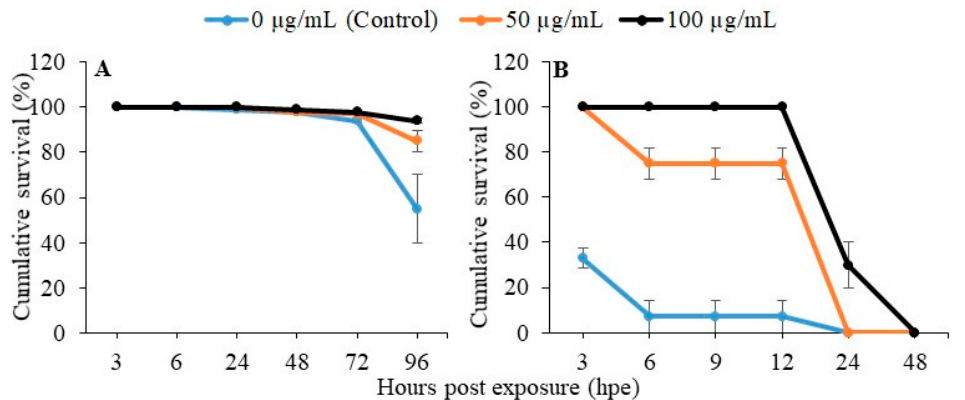
Figure 3. Effect of PGM on disease resistance and thermal tolerance in zebrafish larvae. ( A ) PGM- exposed (50 and 100 µg/mL) zebrafish larvae (at 5 days post exposure (dpe)) were challenged with A. hydrophila (2.91 × 10 8 CFU/mL), and percent survival rate was determined until 96 h post infection (hpi). ( B ) Zebrafish embryos exposed to 50 and 100 µg/mL of PGM and maintained at 28 °C were subjected to heat stress at 40 °C for 48 h, and cumulative survival rate was calculated. The error bars indicate the mean standard error of three